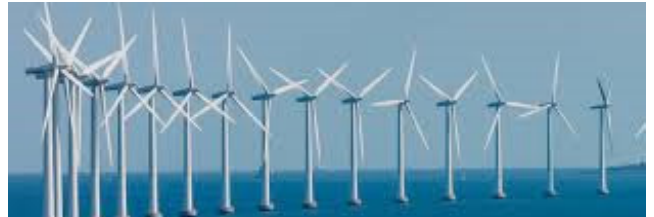
Figure 12. Wind turbine farm